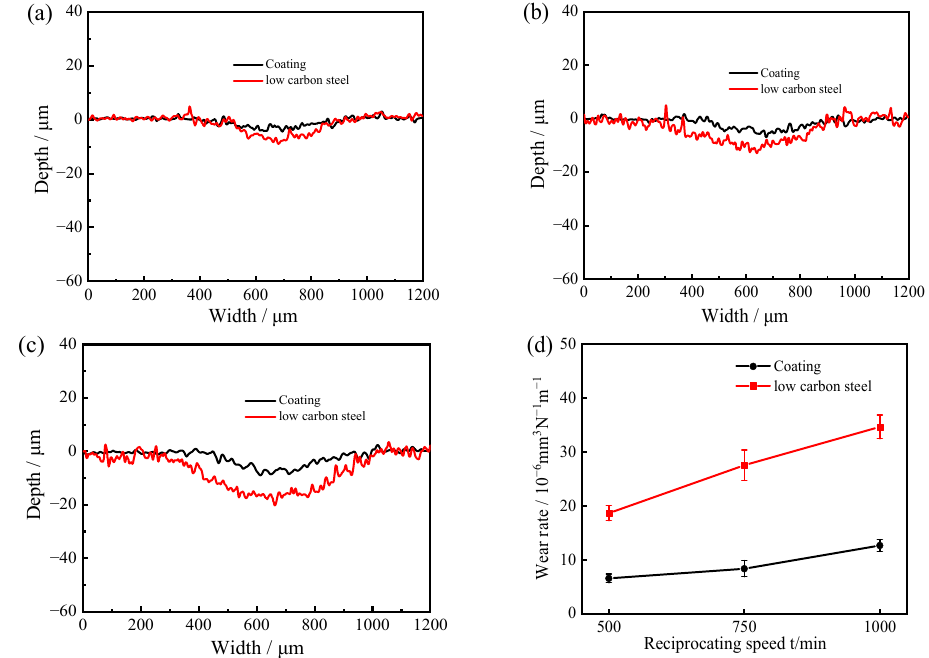
Figure 10. The profiles of the wear section and wear rates of the low-carbon steel and coatings at different sliding speeds ( a ) 500 t/min; ( b ) 750 t/min; ( c ) 1000 t/min; ( d ) Wear rates.